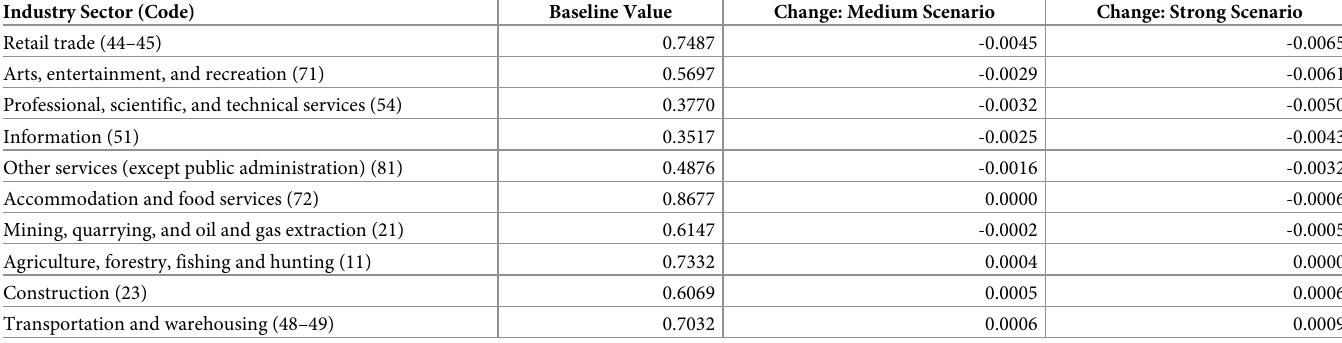
Table 10. Projected change in fraction of jobs susceptible to automation by 2-digit industry sector.